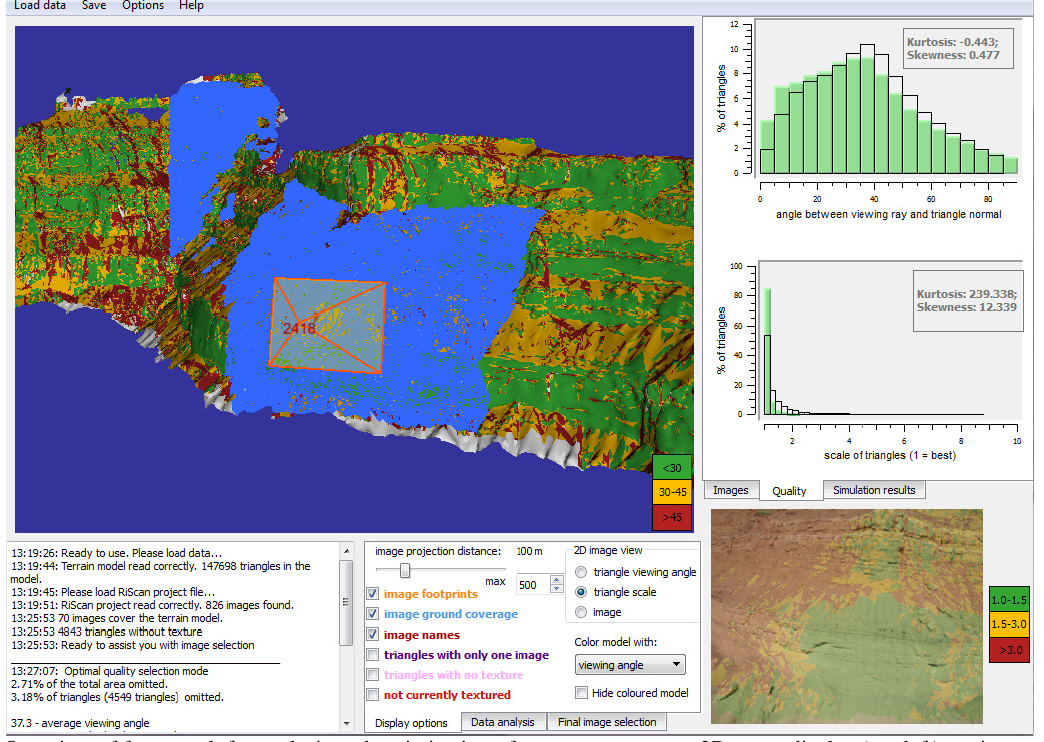
Figure 1. Overview of framework for analysis and optimization of texture parameters. 3D scene display (top left): an image footprint (orange outline) with the corresponding image ground coverage (light blue) and a 3D model coloured with texture viewing angle quality map. Log window (bottom left) provides numerical information. 2D image display (bottom right): map of the scale parameter values overlaid on the image thumbnail. Histograms of texture quality measures (top